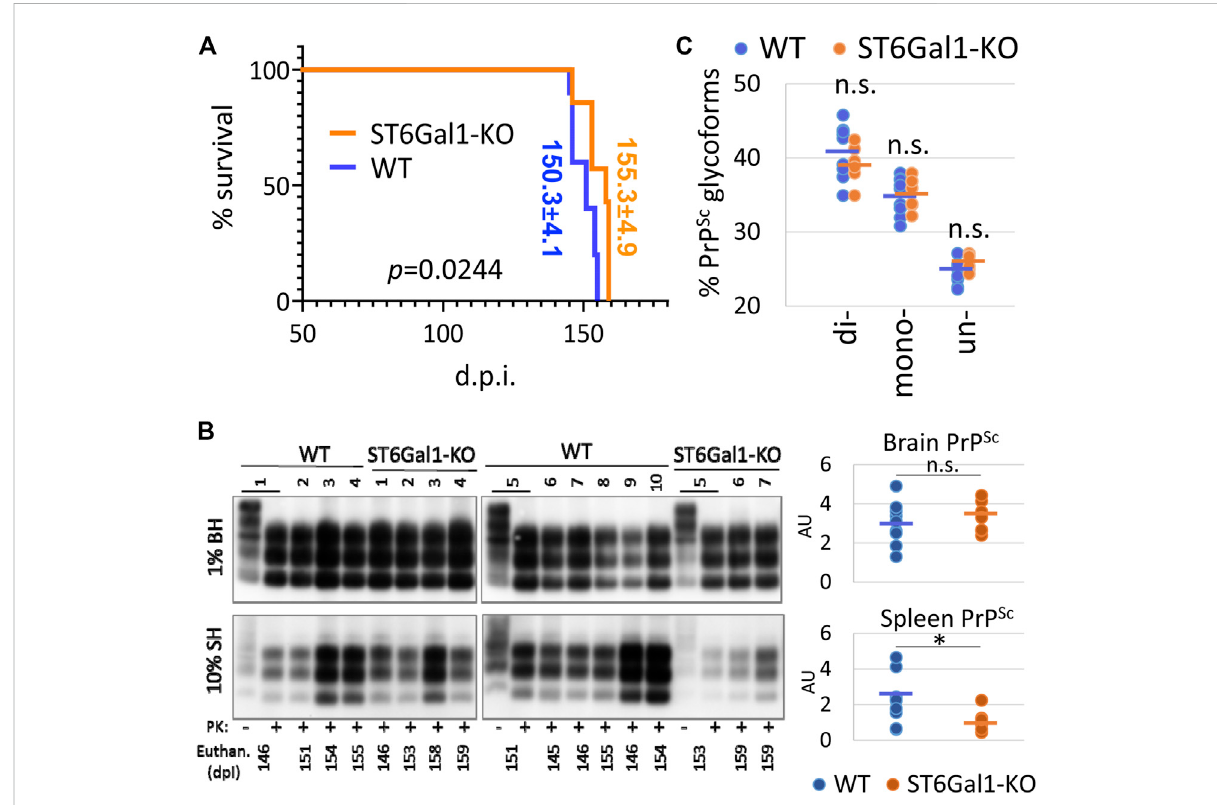
FIGURE 2 A modest impactof ST6Gal1 knockout on theincubation time to disease. (A) Kaplan-Meier survival plot for ST6Gal1-KO and C57Bl/6 (WT) mice inoculatedICwith1%scrapiebrainhomogenateofthe22Lstrain. p valuewascalculatedusingMantel-Coxtestforcomparisonofsurvivalcurves. (B) Western blot analysis and quanti fi cation of PrP Sc in brain homogenates (BH) and spleen homogenates (SH) of ST6Gal1-KO and C57Bl/6 (WT) mice inoculated with 22L. Samples were treated with PK. Untreated (-PK) samples were used as a reference, and were loaded as a 10-fold dilution. Western blots were stained with the ab3531 antibody. PrP Sc amount in brains and spleens were compared using unpaired t -tests and presented as individual animals and means ( n = 10 WT, n = 7 ST6Gal1-KO, * p < 0.05). (C) The percentage of di-, mono- and unglycosylated brain-derived PrP Sc from ST6Gal1-KO and C57Bl/6 (WT) mice inoculated with 22L. Data presented as individual animals and means ( n = 10 WT and n = 7